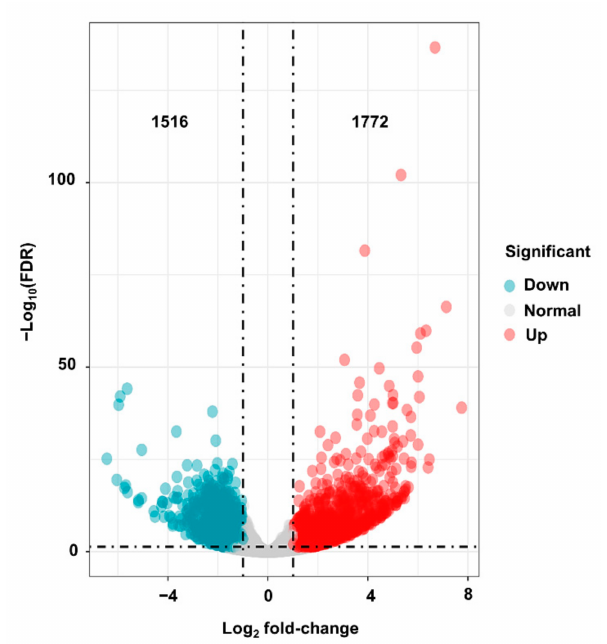
Figure 9. Differentially expressed genes between dnl2 and the wild-type.